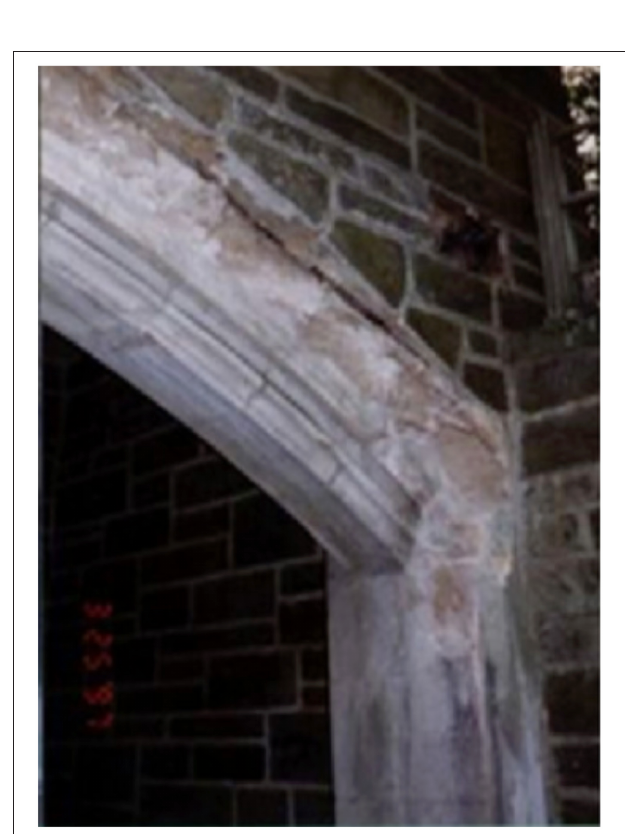
FIGURE 11 | Effects of spalling and calcite growth on an arch on “Building 1.”